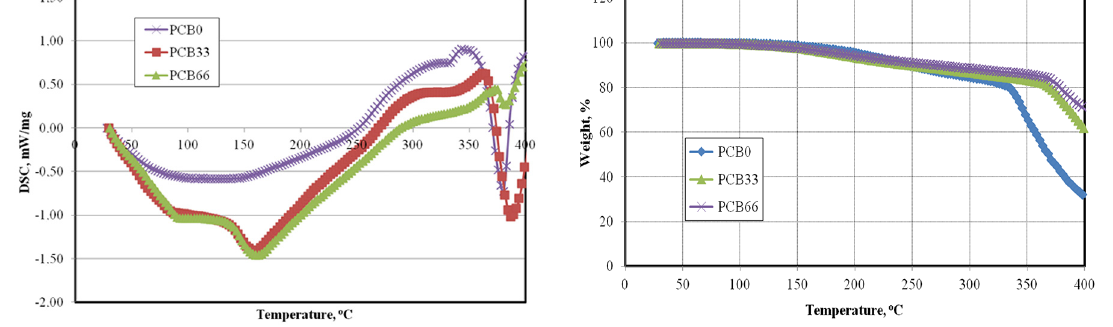
Figure 10. DSC Analysis of PCB series. Figure 11. TG Analysis of PCB